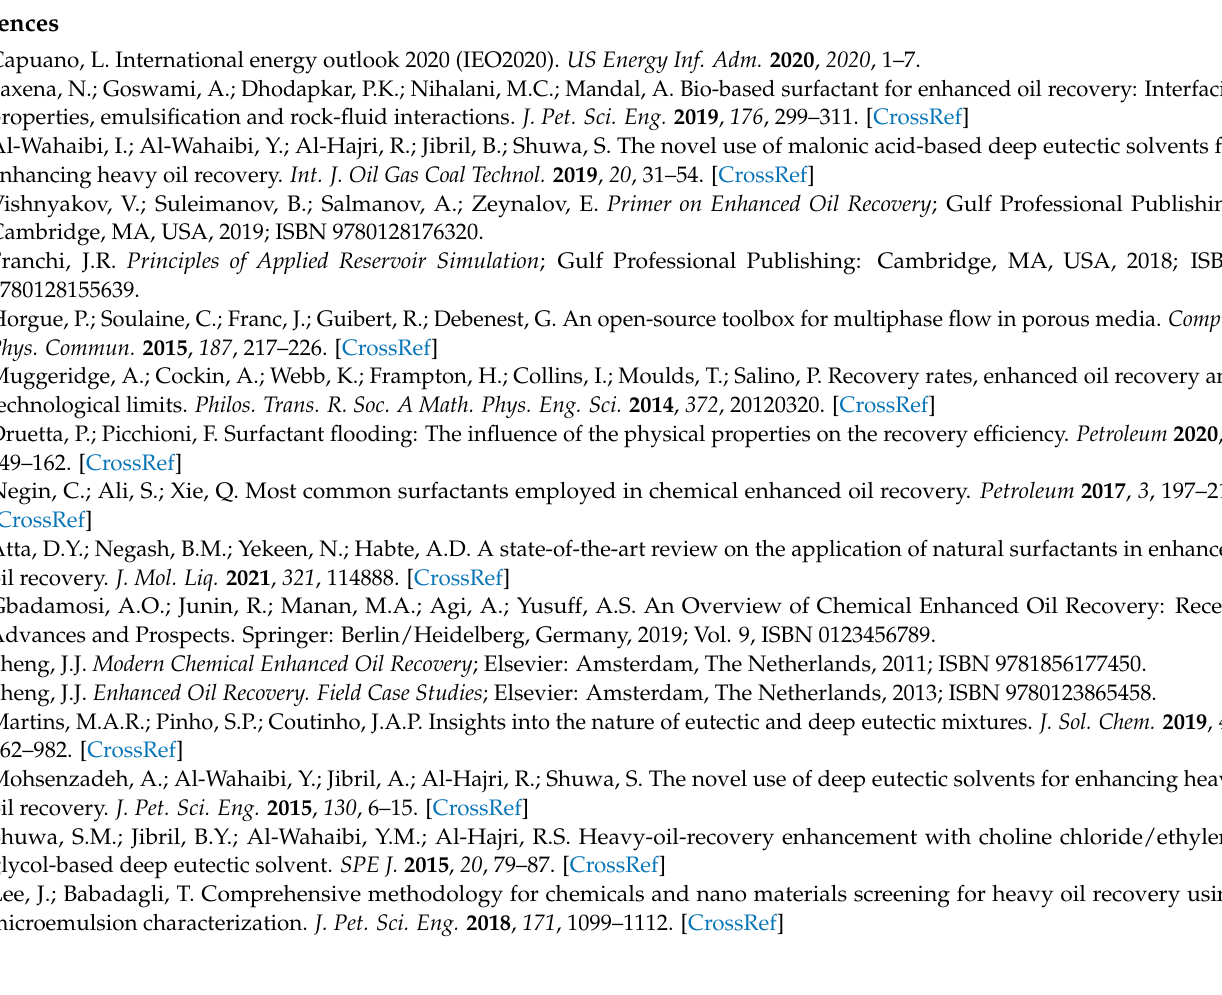
Table S1: Melting temperatures for AOT + PEG mixtures. Table S2: Physical properties for the AOT + PEG-600